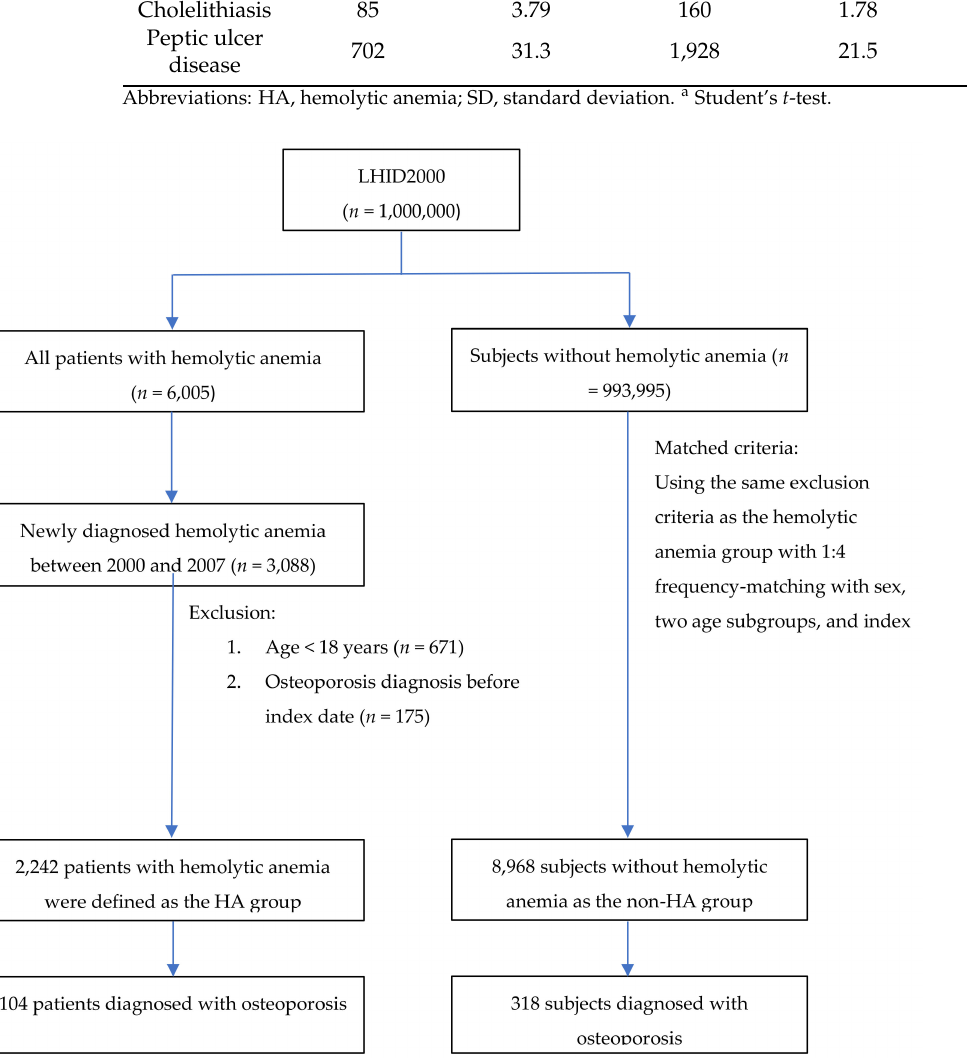
Figure 1. The selection process of the participants in the cohort study. Abbreviations: HA, hemolytic anemia; LHID, Longitudinal Health Insurance